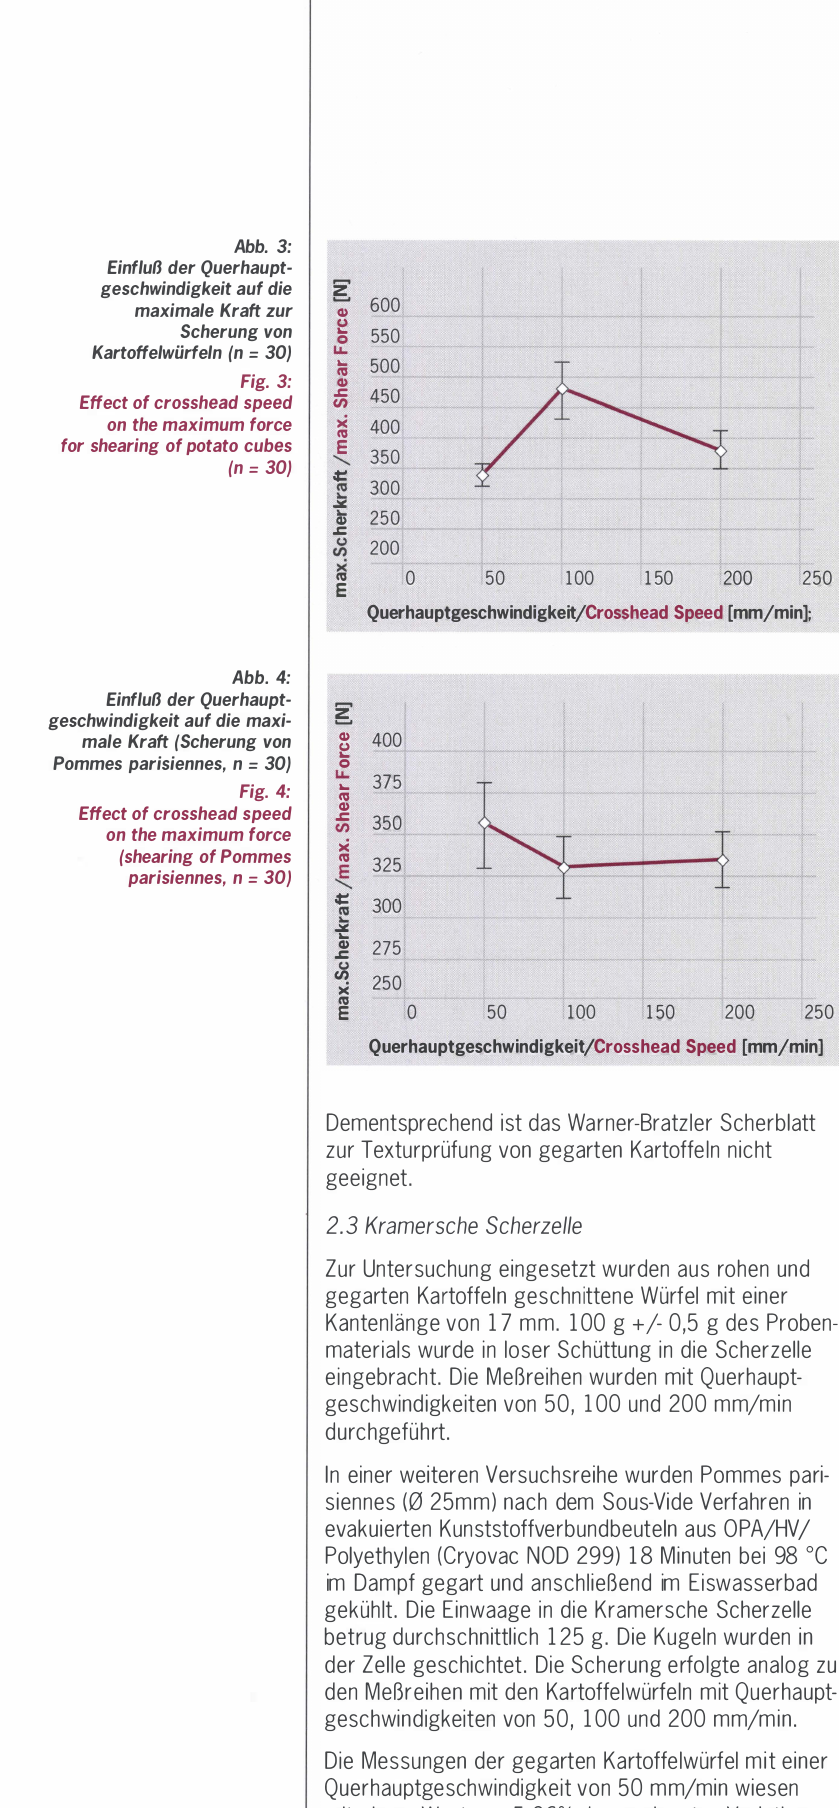
Fig. 4: Effect of crosshead speed on the maximum force (shearing of